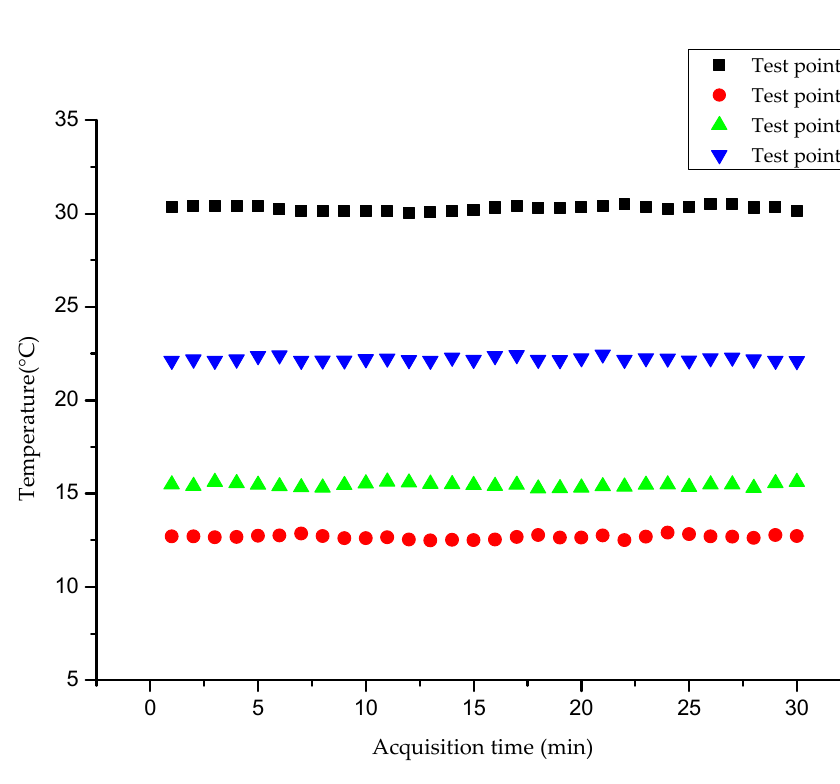
Figure 9. Temperature data collection of four test points at 30 °C, 60%, 0.2 m 3 /s.